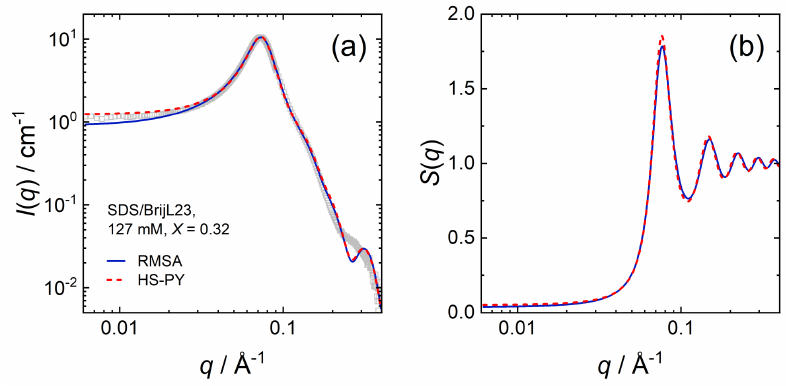
Figure 9. ( a ) SANS data for the SDS/BrijL23 mixture with a total surfactant concentration of 127mM and mixing ratios X =[SDS]/([SDS]+[BrijL23])=0.32. Symbols are experimental scattering data. Two model fits to the data by Equation (1) are compared: the blue, solid line is fitted using the RMSA structure factor. The red, dashed line is the result, using the HS-PY structure factor. Extracted structure factors S ( q ) are displayed in panel ( b